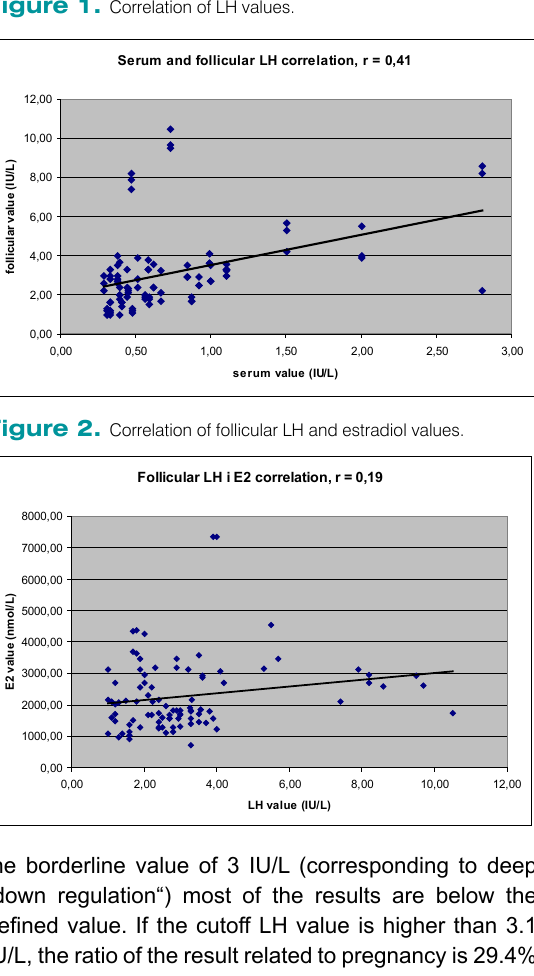
Figure 1. Correlation of LH values.